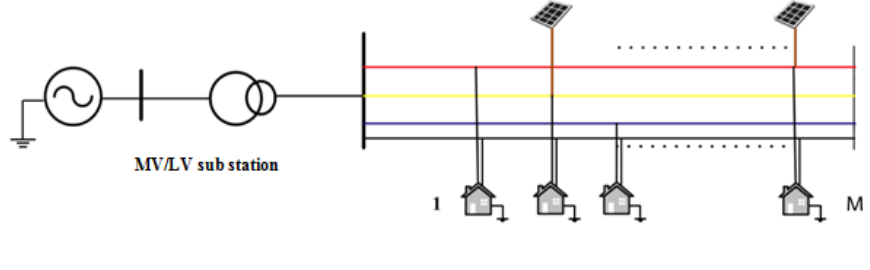
Figure 2: A generic distribution network.